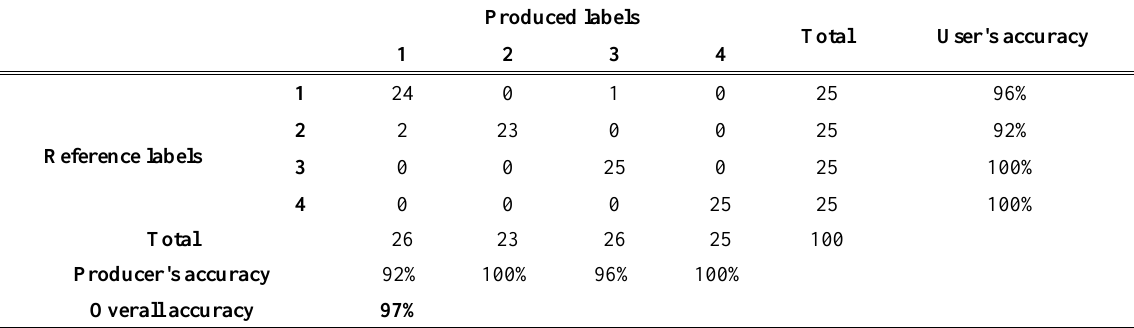
Table 5 . The error matrix used to report accuracy results in Bari with land cover types indicated as follows: 1 = built-up, 2 = vegetation, 3 = barren land, 4 = water body.